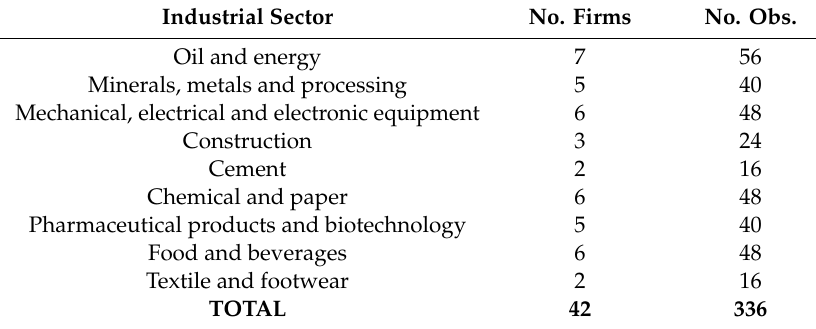
Table 1. Distribution by